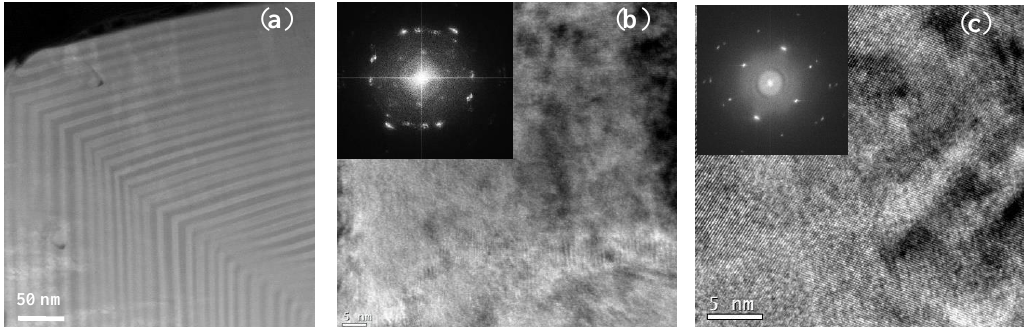
Figure 8. FIB/TEM images of the multilayer TiAlCrSiYN/TiAlCrN coatings: ( a ) FIB cross-section of multilayer TiAlCrSiYN/TiAlCrN coating on the cutting edge; ( b ) HRTEM with SAED (selected area electron diffraction pattern) diffraction patterns of 2 µm bi-multilayer coating; ( c ) TEM-HRTEM with SAED diffraction patterns of 3 µm bi-multilayer coating.